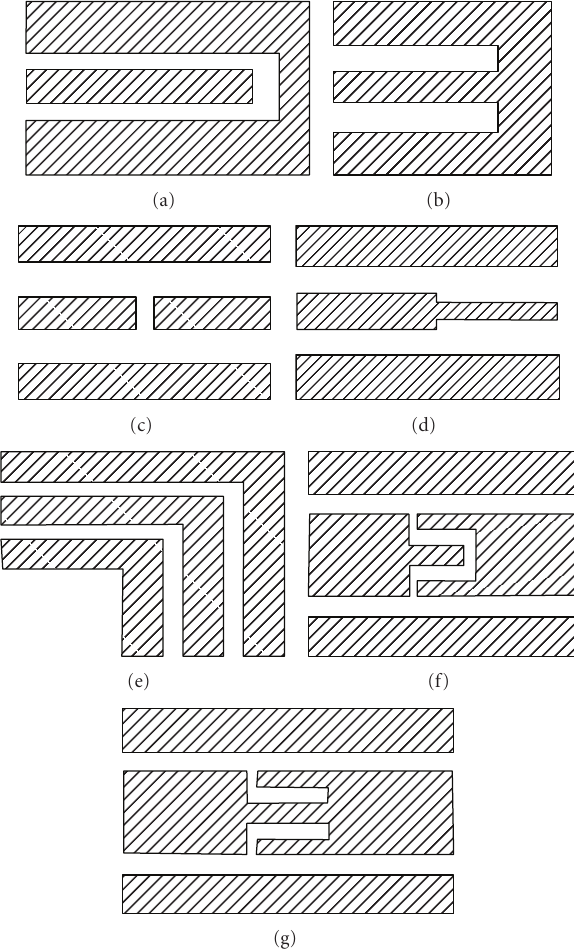
Figure 1: CPW discontinuities (a), open-end (b), short-end (c), gap (d), step (e), right-angled bend (f), open-end series stub (g) and short-end series stub.